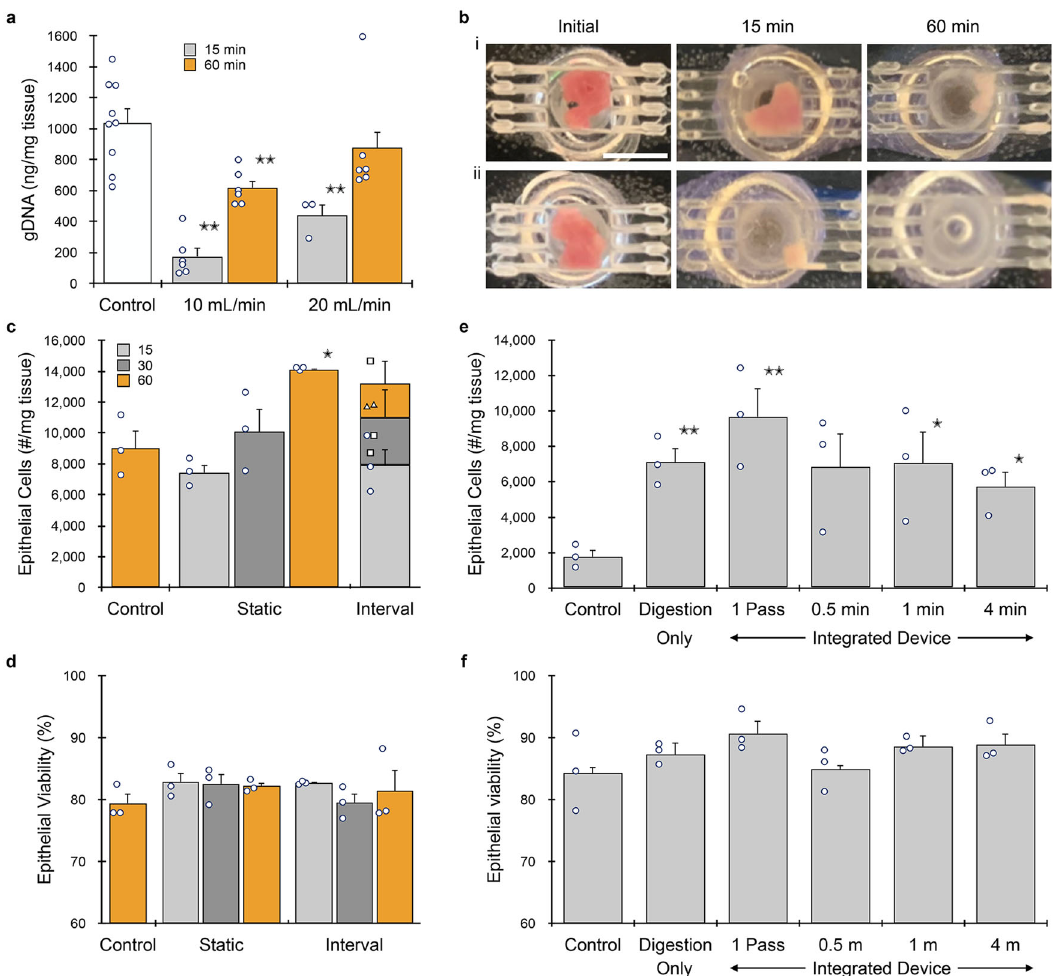
Fig. 2 Device optimization using murine kidney. a Kidneys ( n = 3 to 9 independent samples) were harvested, minced, and processed using the minced digestion device at 10 or 20 mL/min fl ow rate for 15 or 60 min, and total genomic DNA (gDNA) was quanti fi ed. gDNA was extracted directly from the control, and thus this represents maximum recovery. Results at 20 mL/min fl ow rate were superior, particularly at the shorter time point. b Pictures of tissue within the minced digestion device chamber before and after 15 or 60 min of processing at 10 (i) or 20 (ii) mL/min fl ow rate. Signi fi cant tissue remained at 10 mL/min, while tissue was largely absent at 20 mL/min. c Single EpCAM + epithelial cells were quanti fi ed by fl ow cytometry after samples ( n = 3) were processed with the minced digestion device for 15, 30, or 60 min. We also evaluated recovery of sample at different time intervals, with more collagenase added to continue processing of remaining tissue. d Epithelial cell viability was ~80% for all control and device conditions ( n = 3). e Samples ( n = 3) were processed with the integrated dissociation/ fi lter device following 15 min of digestion device treatment. A single pass through the integrated device produced optimal results. f Epithelial cell viability was at ~85 – 90% for all conditions ( n = 3). Data are presented as mean values ± SEM from at least three independent experiments. Circles indicate values for experimental replicates. For the stacked plot, experimental replicates are indicated by circles at 15 min, squares at 30 min, and triangles at 60 min. Two-sided T test was used for statistical testing. Stars indicate p < 0.05 and double stars indicate p < 0.01 relative to the control at the same digestion time. p values for all comparisons are presented in the Source Data fi